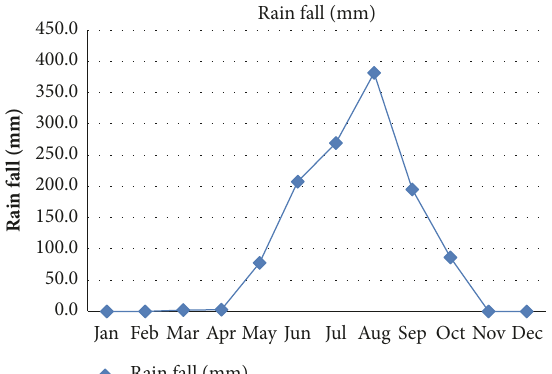
Figure 3: Rainfall during the cropping season (2016, Tigray Regional Meteorological Agency